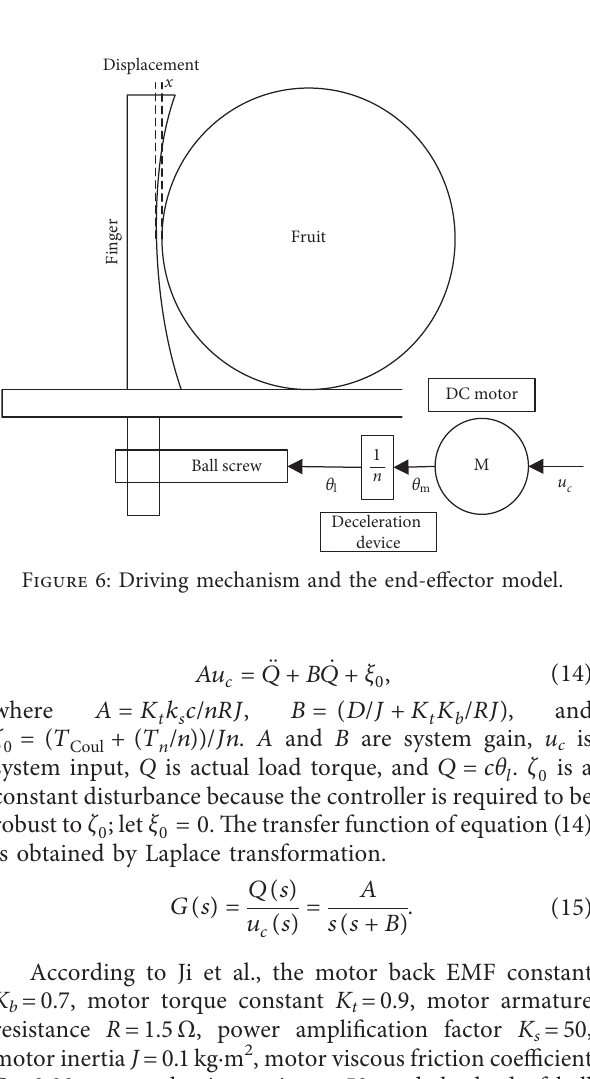
Figure 5: The grasping experimental platform for apple harvesting robot.